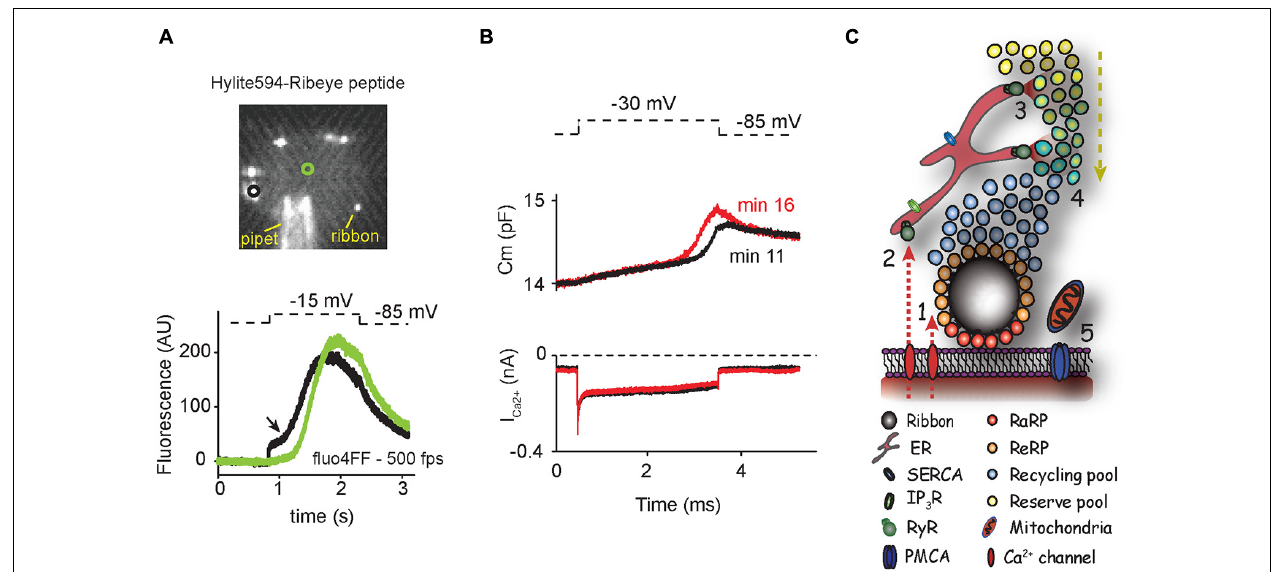
release was first obtained during prolonged moderate depolarization (black trace). The onset of superlinear release was shifted by equivalent calcium load 5 min later (red trace). (C) Intracellular calcium stores could modulate the recruitment of vesicles to the plasma membrane. Calcium influx through L-type calcium channels triggers exocytosis of synaptic vesicles near the active zone (1). In parallel, calcium also activates RyRs (2), triggering the release of calcium stored in the ER at sites far from the ribbon (3). CICR allows the recruitment of vesicles from reserve pools to the vicinity of the ribbon (4). (ER = endoplasmic reticulum; IP 3 R = inositol triphosphate receptor; SERCA = sarco/endoplasmic reticulum calcium ATPase; RaRP = rapid releasable pool; ReRP = readily releasable pool.) Mitochondria and calcium pumps maintain homeostatic calcium levels in cytoplasm (5). Arrows depict the direction of calcium influx and vesicle